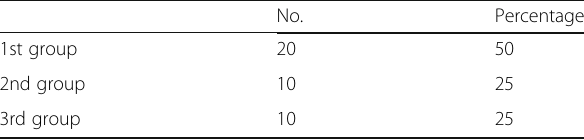
Table 3 Postoperative functional status according to (Karnofsky performance